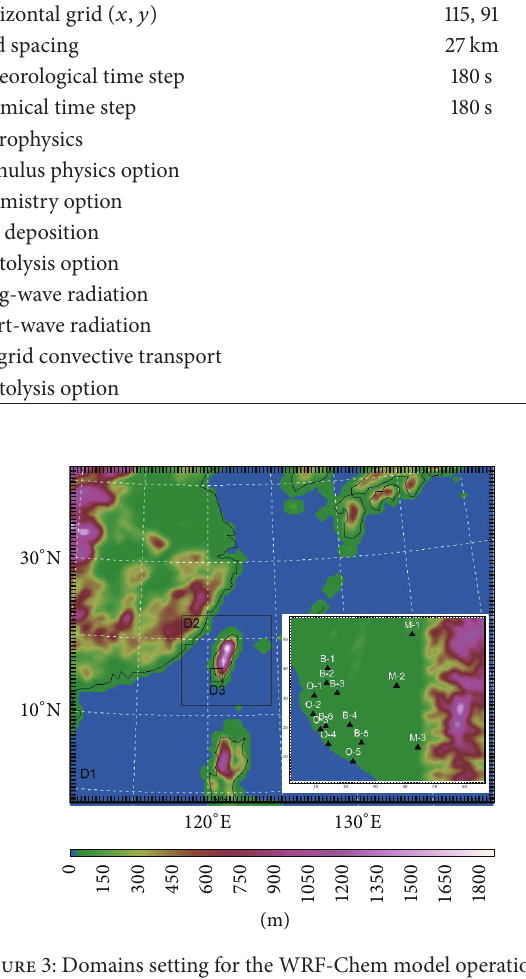
to verify the simulated results. Kaohsiung City located in the southwest of Taiwan and neighboring Pingtung